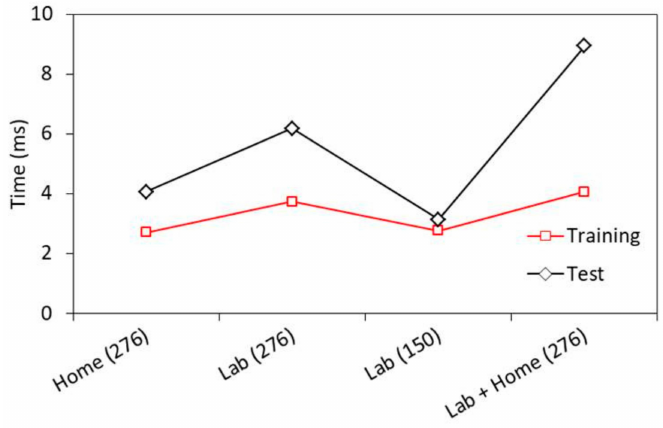
Figure 13. SVM classifier execution